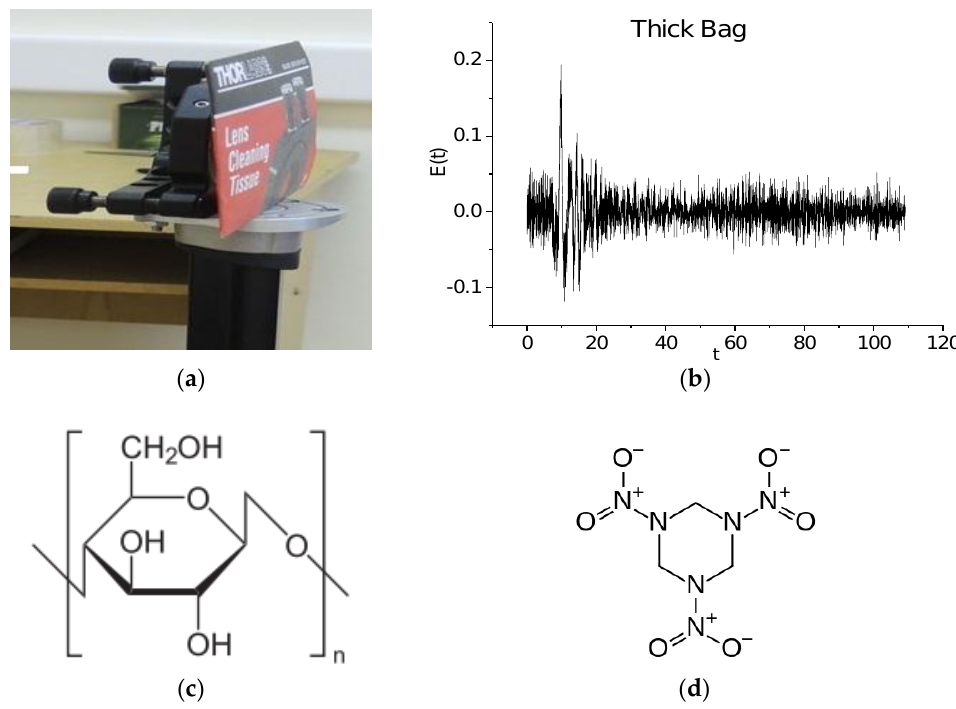
Figure 2. Thick paper bag ( a ) investigated in real conditions at long distance of about 3.5 m; the Thick Bag signal ( b ) at the time interval t = [0, 110] ps; chemical formulae of cellulose ( c ) and RDX ( d ).